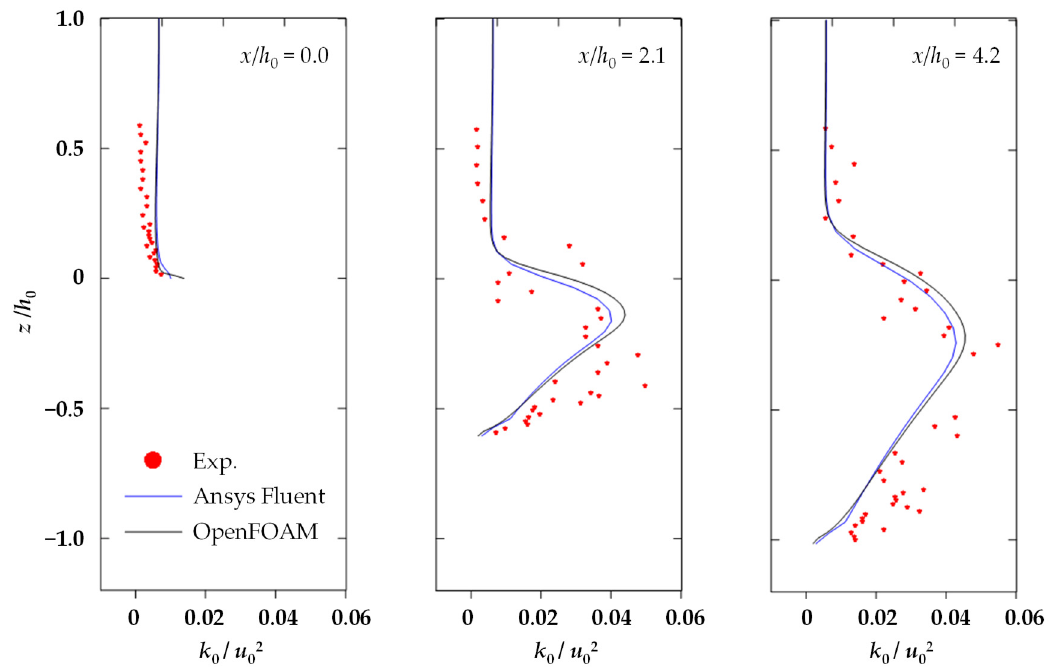
Figure 9. Comparison of turbulent kinetic energy profile results of laboratory experiment, Open- FOAM, and Ansys Fluent at downstream distances of x/h 0 = 0.0, 2.1, and 4.2.